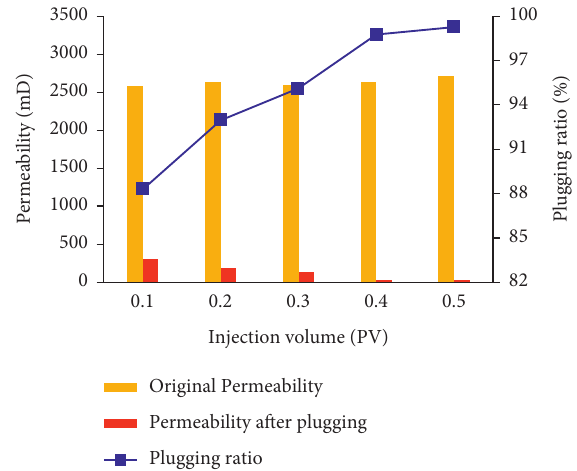
Figure 3: Plugging ratio with different models under different